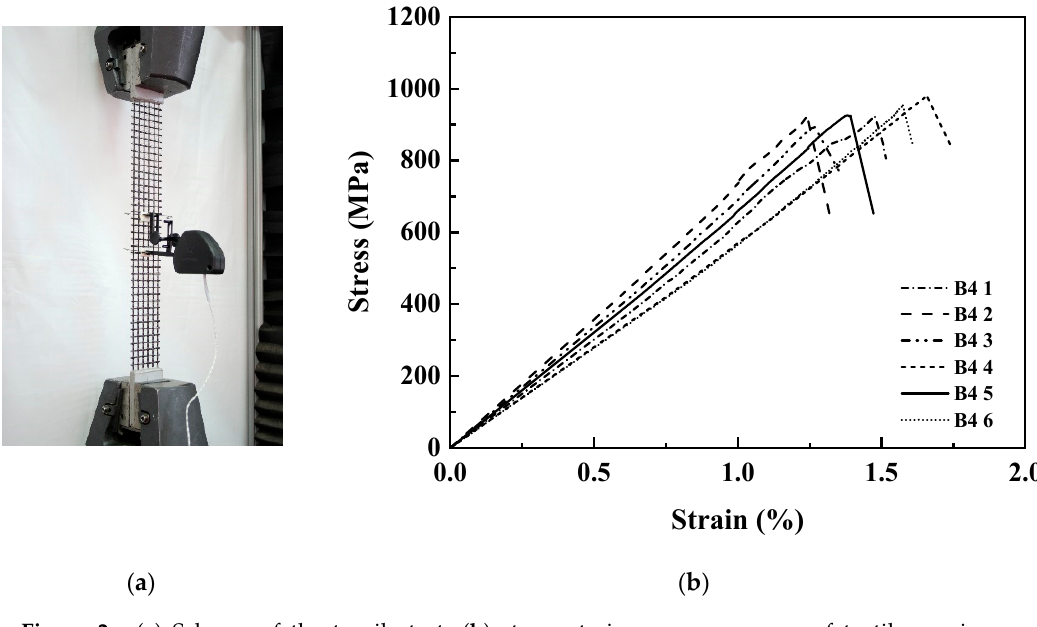
Figure 2. ( a ) Scheme of the tensile test; ( b ) stress–strain response curves of textile specimens under tension.